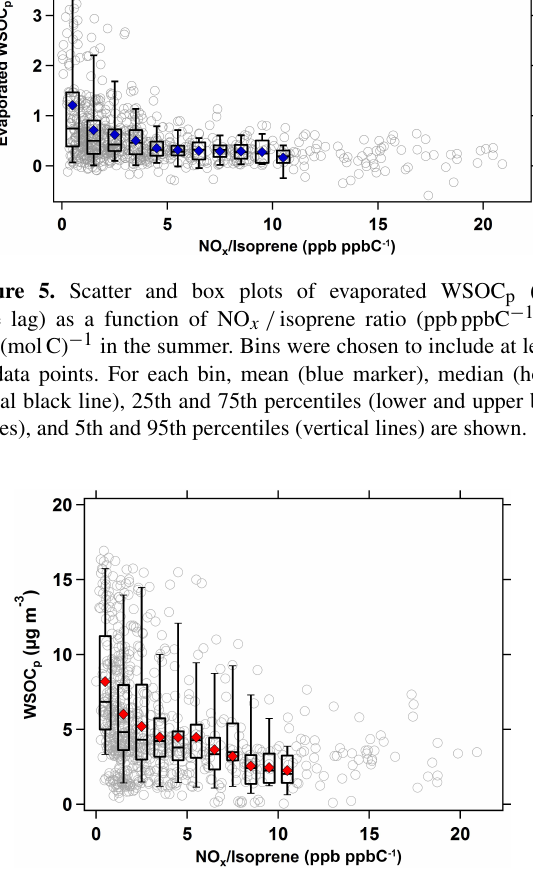
Figure 6. Scatter plot of WSOC p as a function of NO x / isoprene ratio (ppbppbC − 1 or mol(molC) − 1 ) in the summer. Symbols and bins are consistent with those defined in Fig.